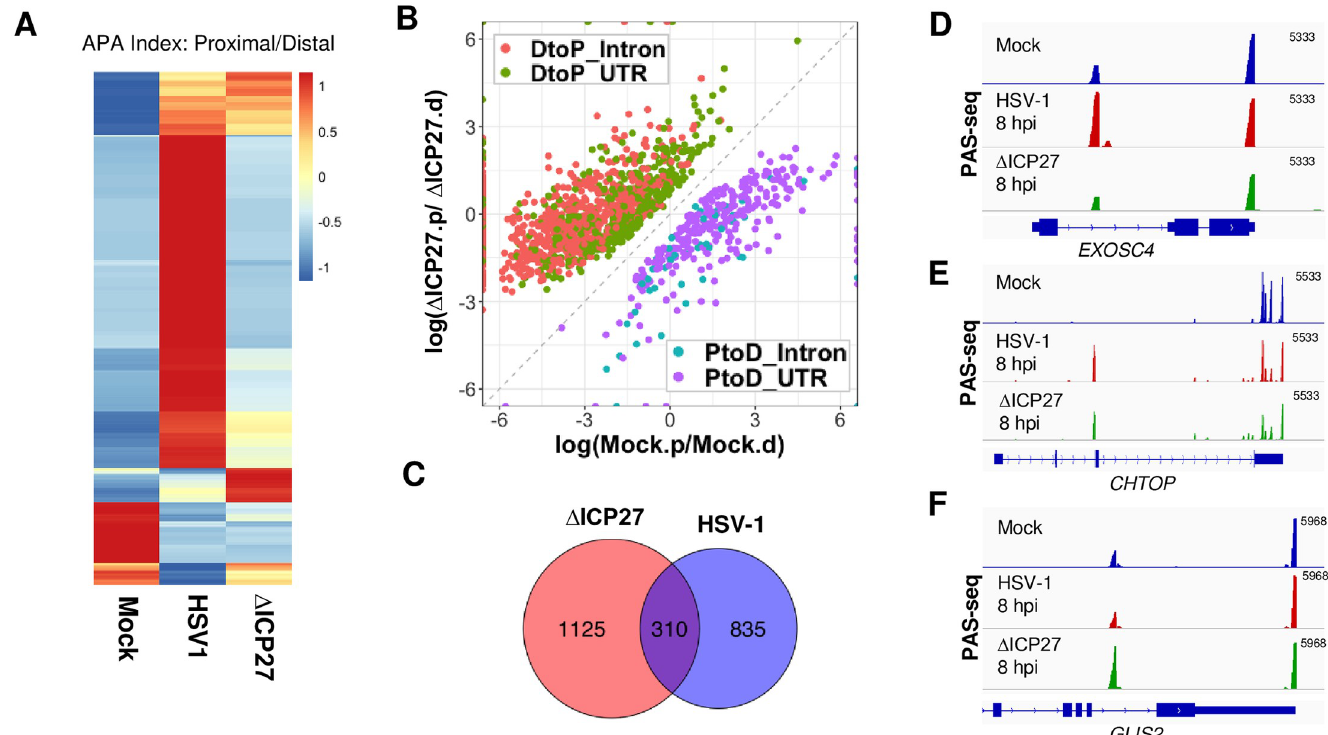
Fig 3. ICP27-dependent and -independent HSV-1-induced APA changes. (A) A heat map showing the APA index of all the genes that displayed significant APA changes as shown in Fig 1A in mock, wild-type or Δ ICP27 HSV-1-infected HeLa cells (8 hpi). Data was scaled by row. (B) A scatter plot showing significant APA differences between mock- and Δ ICP27 HSV-1-infected HeLa cells (8 hpi). (C) A Venn diagram showing the overlap between proximal PAS that displayed significant APA changes induced by the wild-type or Δ ICP27 HSV-1. (D-F) PAS-seq tracks of mock-, wild-type HSV-1, or Δ ICP27 HSV-1-infected HeLa cells at 8 hpi.